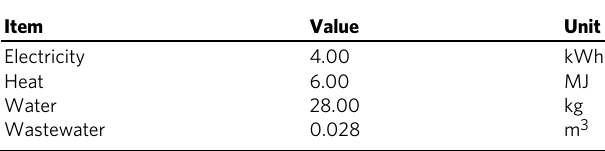
Table 1 Energy and water consumption of food preparation per capita per day 6 .